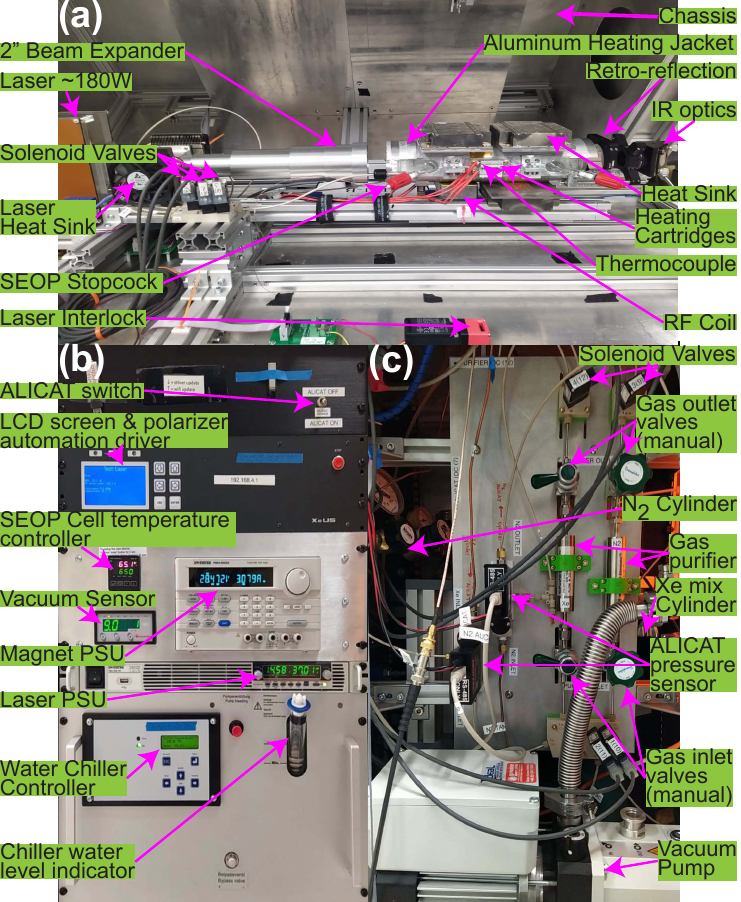
Figure 2. Annotated photographs of the GEN-3 129 Xe hyperpolarizer: ( a ) upper chassis with magnetic solenoid coil removed to show the SEOP cell, NMR coil, and heating jacket, ( b ) front panel housing the driver module, pump laser and magnetic solenoid coil power supply units, temperature and vacuum sensors, and water chiller, and ( c ) side panel housing the gas-handling manifold, gas cylinders and vacuum